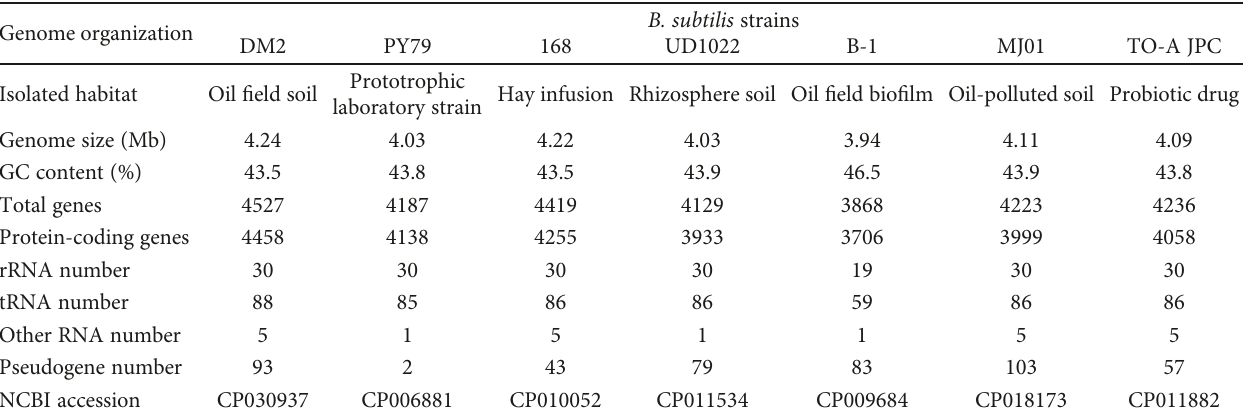
Table 2: Genomic characteristics of several Bacillus subtilis